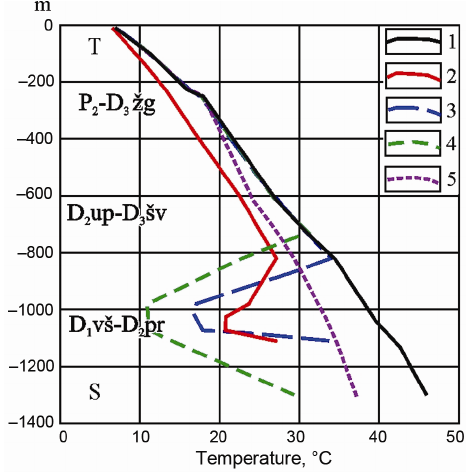
Fig. 4. Temperature of the underground in the injection well 1i: 1 – undisturbed; in 2008: 2 – measured; 3 – modelled; predict-